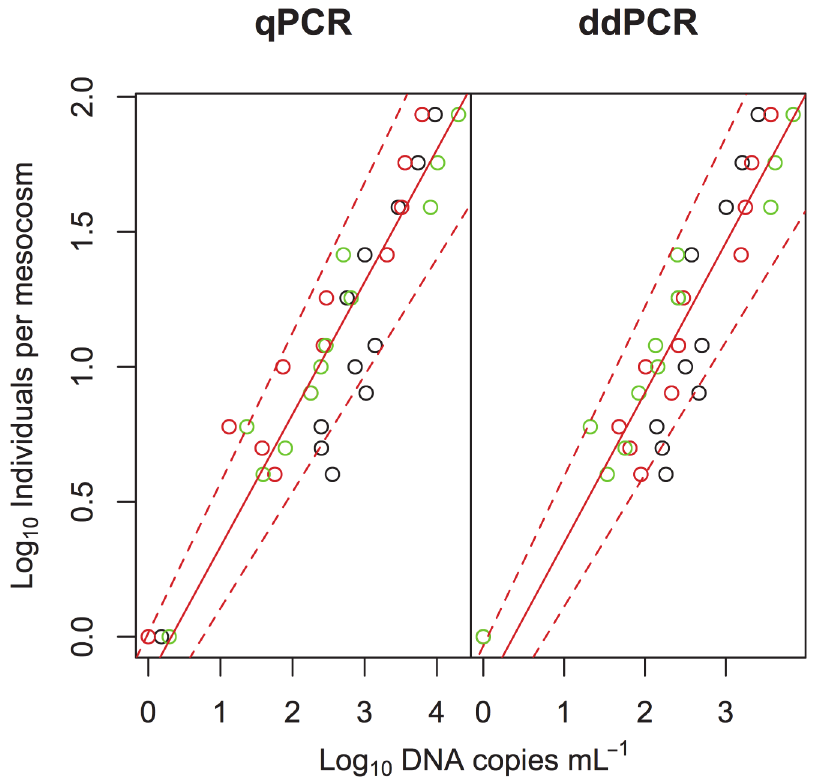
Fig 3. Relationships between eDNA concentrations of common carp and their abundance in the mesocosm experiment. Black, red, and green symbols indicate samples collected on days 1, 2, and 3, respectively. Solid red and dashed red lines indicate Type II regression and 95% CI,